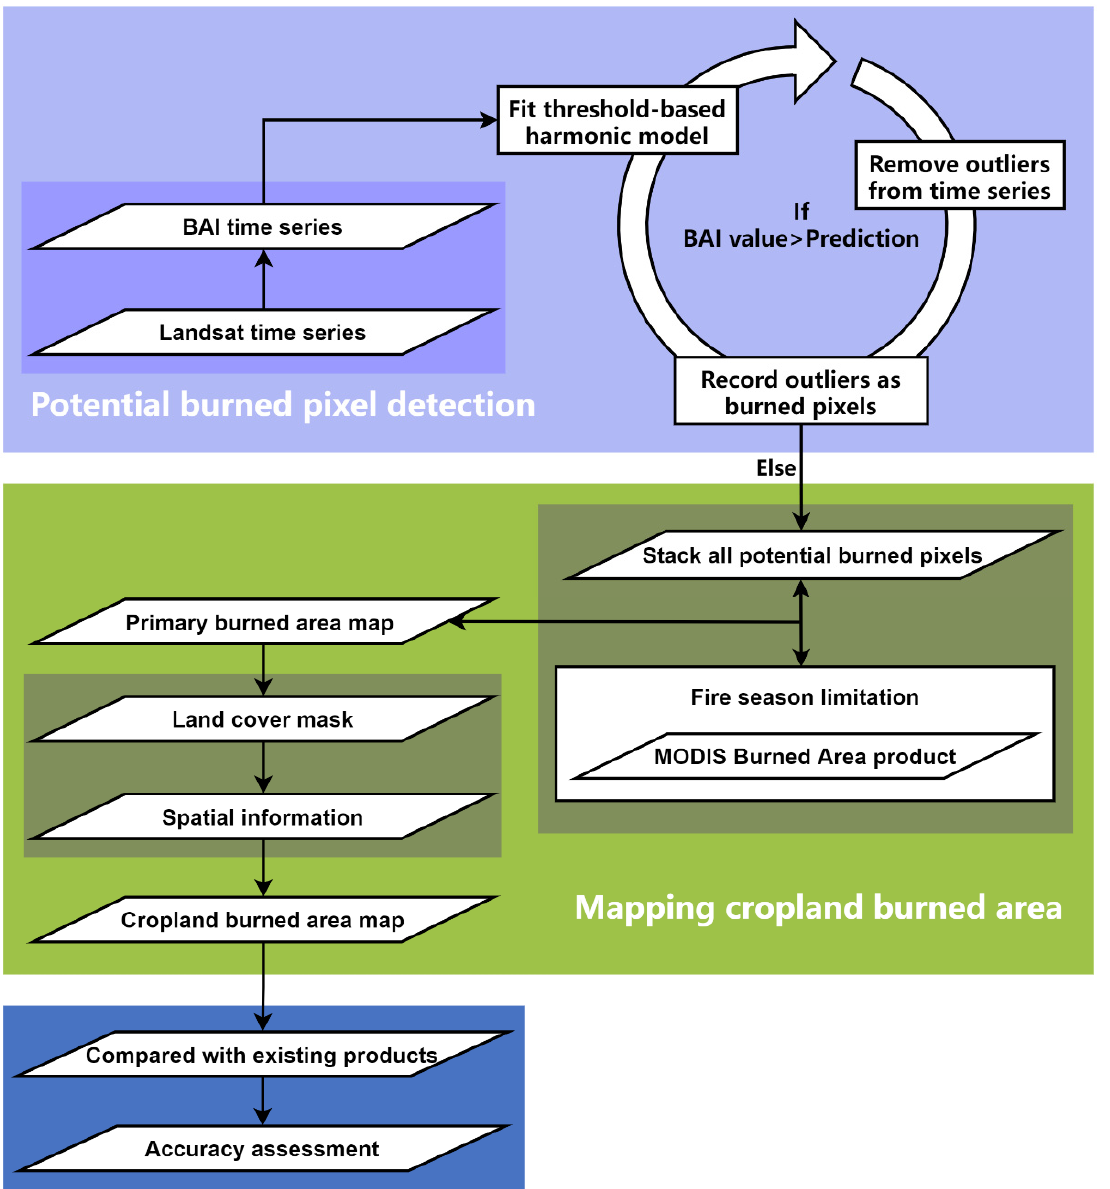
Figure 2. An overview of the cropland burned area detection algorithm.